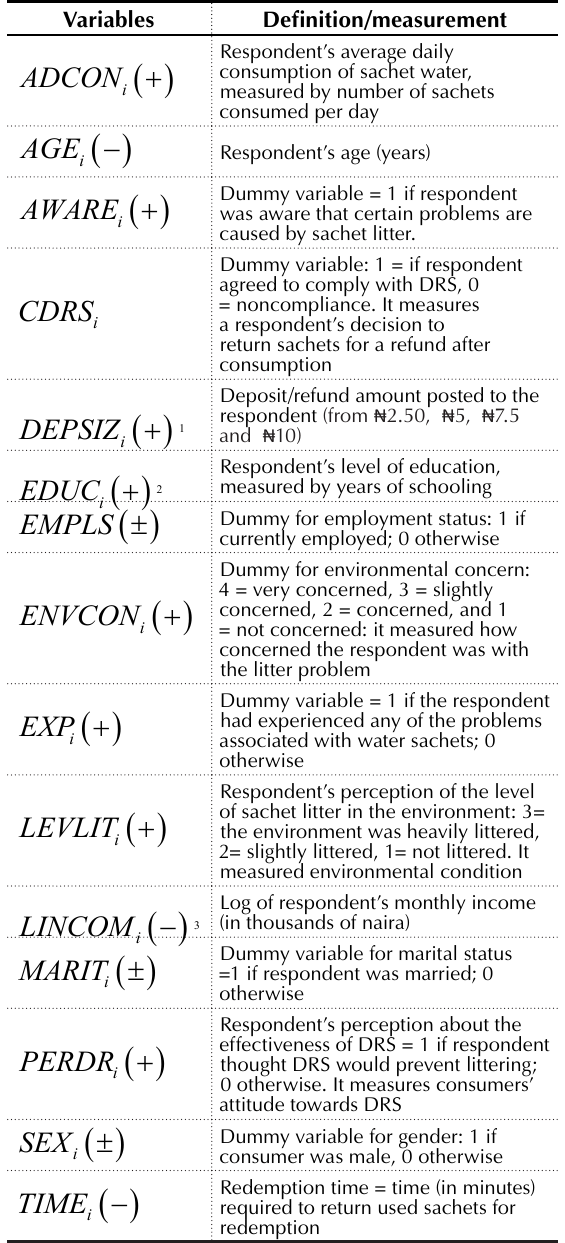
Table 1. Definition and measurement of